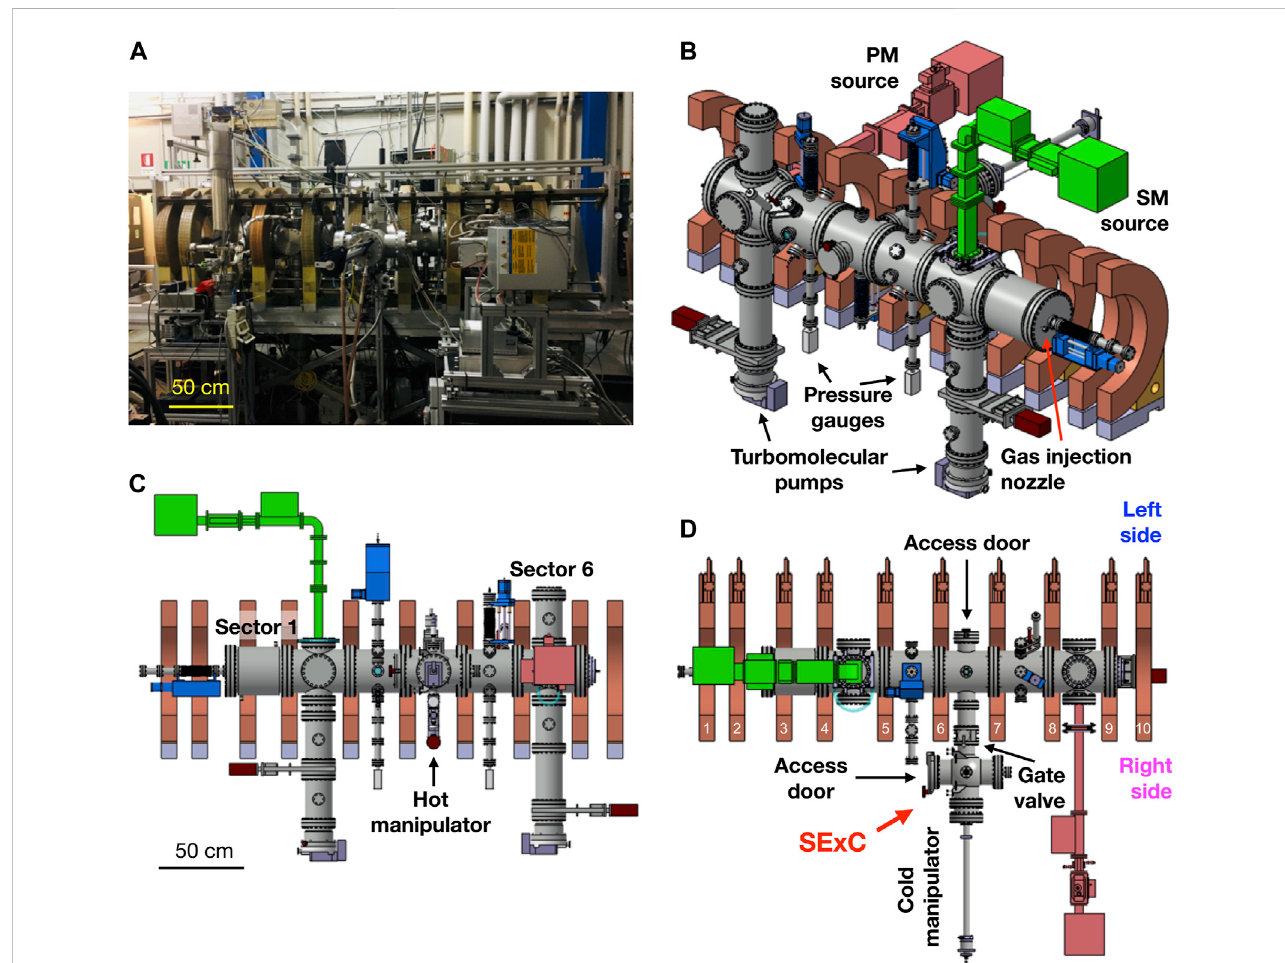
FIGURE 1 A photograph of GyM (A) . Schematics of the device (B – D) with the main components in evidence. The lateral (C) and the top (D) views show the sector and coil numbering,